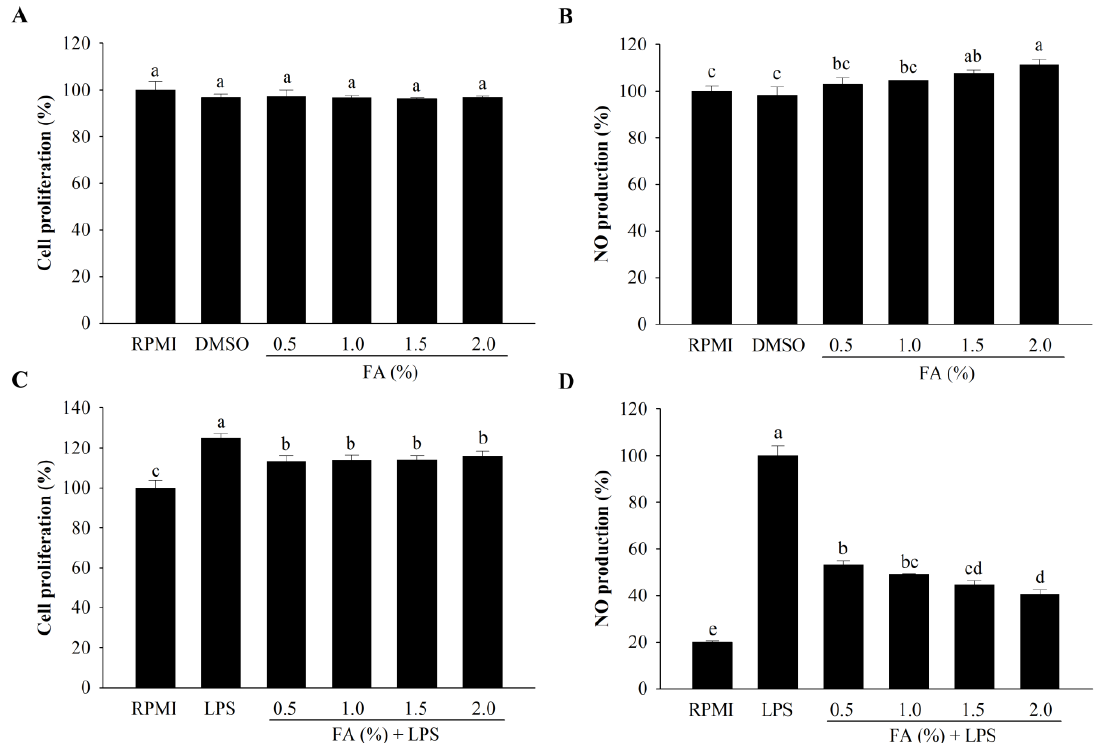
Figure 2. The effect of HAGF on cell proliferation and production of NO. ( A ) RAW264.7 cell proliferation. ( B ) NO production in RAW264.7 cells. ( C ) LPS-stimulated proliferation. ( D ) LPS-stimulated NO production. Values are shown as means ± SD ( n = 3). Different letters (a – e) are used to reflect statistical differences at p < 0.05. FA = fatty acid.